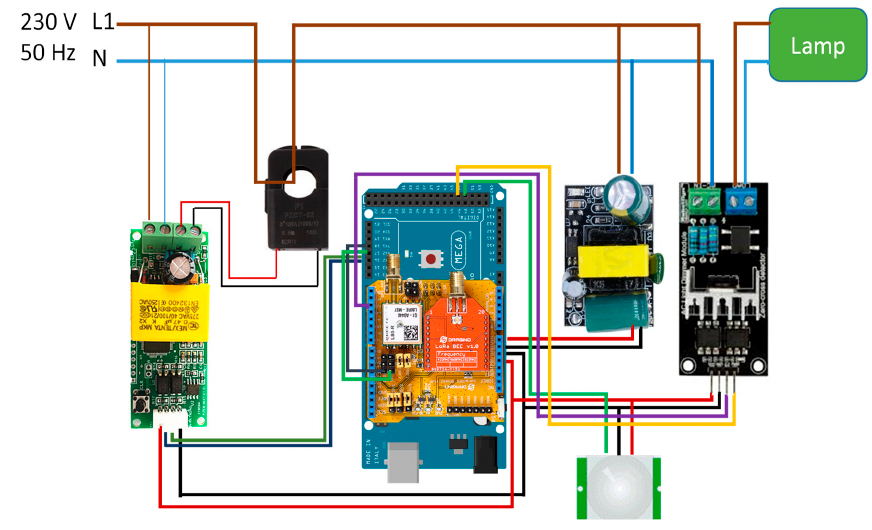
Figure 5. Wiring diagram of MCDSL. Table 4. MCDSL components cost.